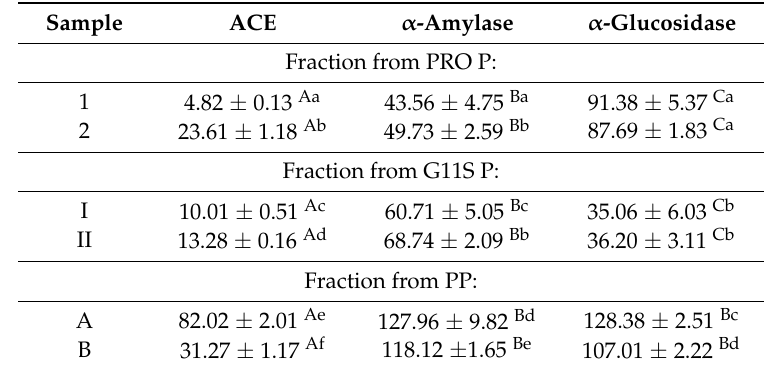
Table 4. IC 50 ( µ g/mL) of peptide fractions for inhibitory activity of enzymes involved in metabolic syndrome